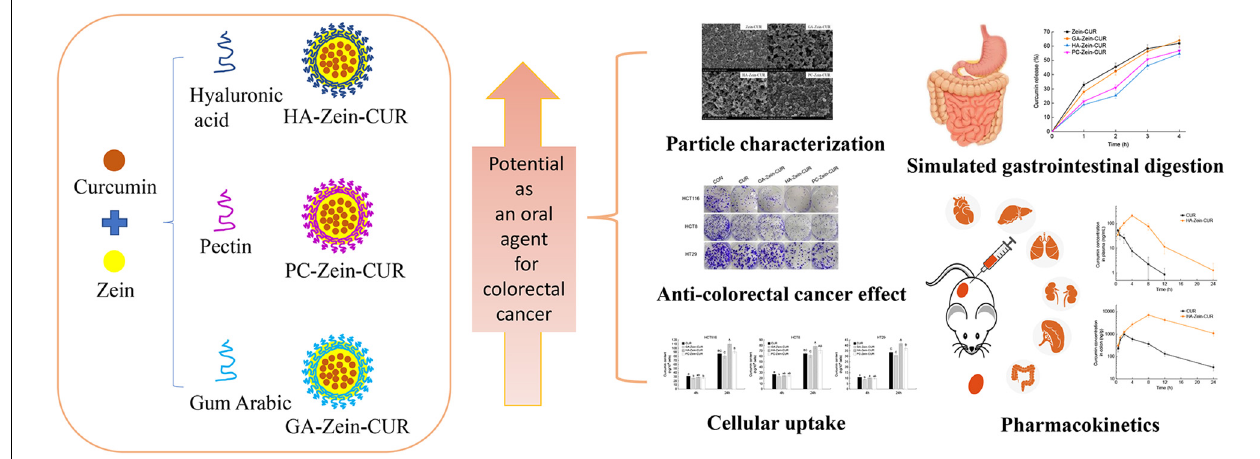
FIGURE 1 | Experimental scheme. The evaluation of the potential of PS-Zein-CUR an oral agent for CRC therapy: physicochemical properties, anti-CRC effects, cellular uptake, and gastrointestinal simulated digestion in vitro and pharmacokinetics and tissue distribution in